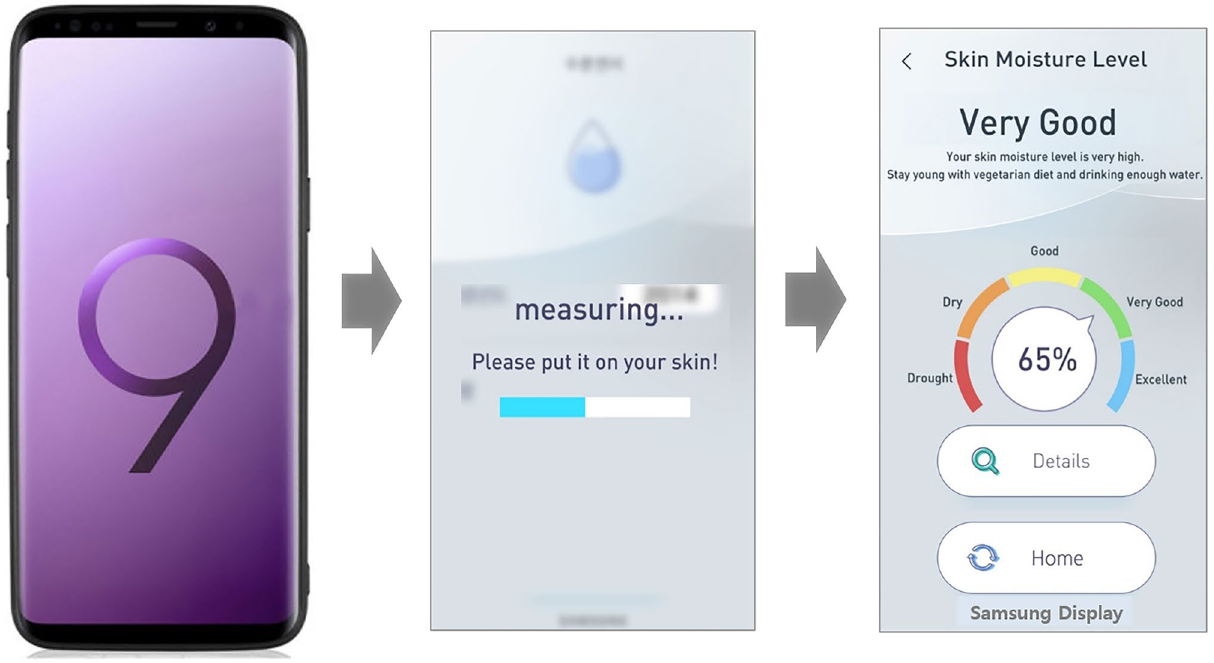
Figure 2. Scheme for skin hydration measurement using smartphone.